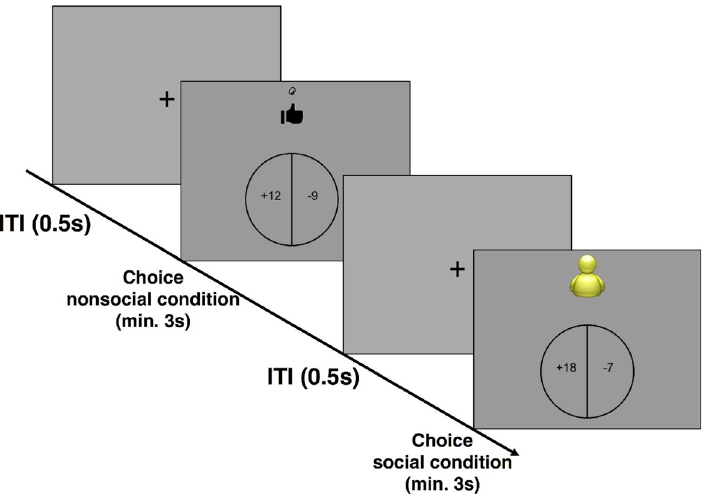
Figure 1. Behavioral paradigm. Timeline of the behavioral paradigm. Participants had to decide whether to accept or reject a gamble with depicted gains and losses. Determination of current gamble’s outcomes was depicted above the gamble. A coin-tossing hand indicated that the gamble’s outcome was decided by the participant with a coin toss (nonsocial condition). A manikin indicated that the gamble’s outcome was decided by another participant (social